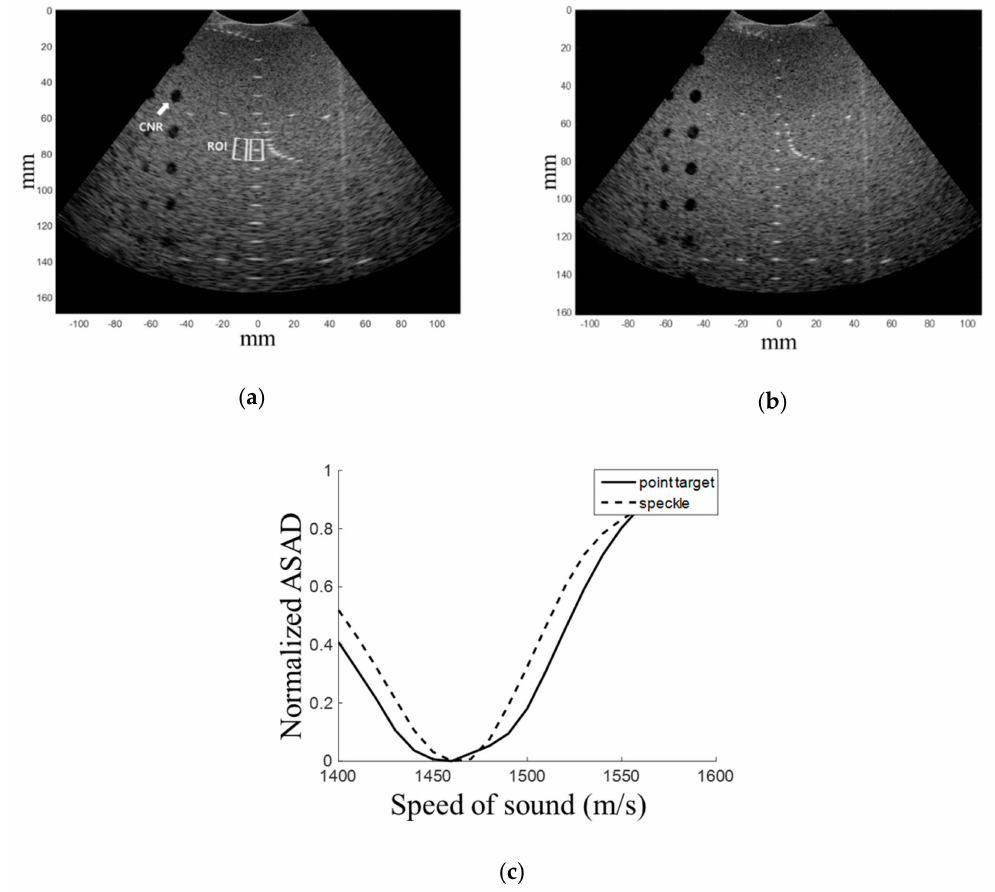
Figure 2. Experiment results of the homogeneous medium. B-mode image with a sound speed of ( a ) 1540 m / s, ( b ) 1460 m / s and ( c ) normalized ASAD values for the region of interest (ROI) of the point target (solid line) and speckle regions (dotted